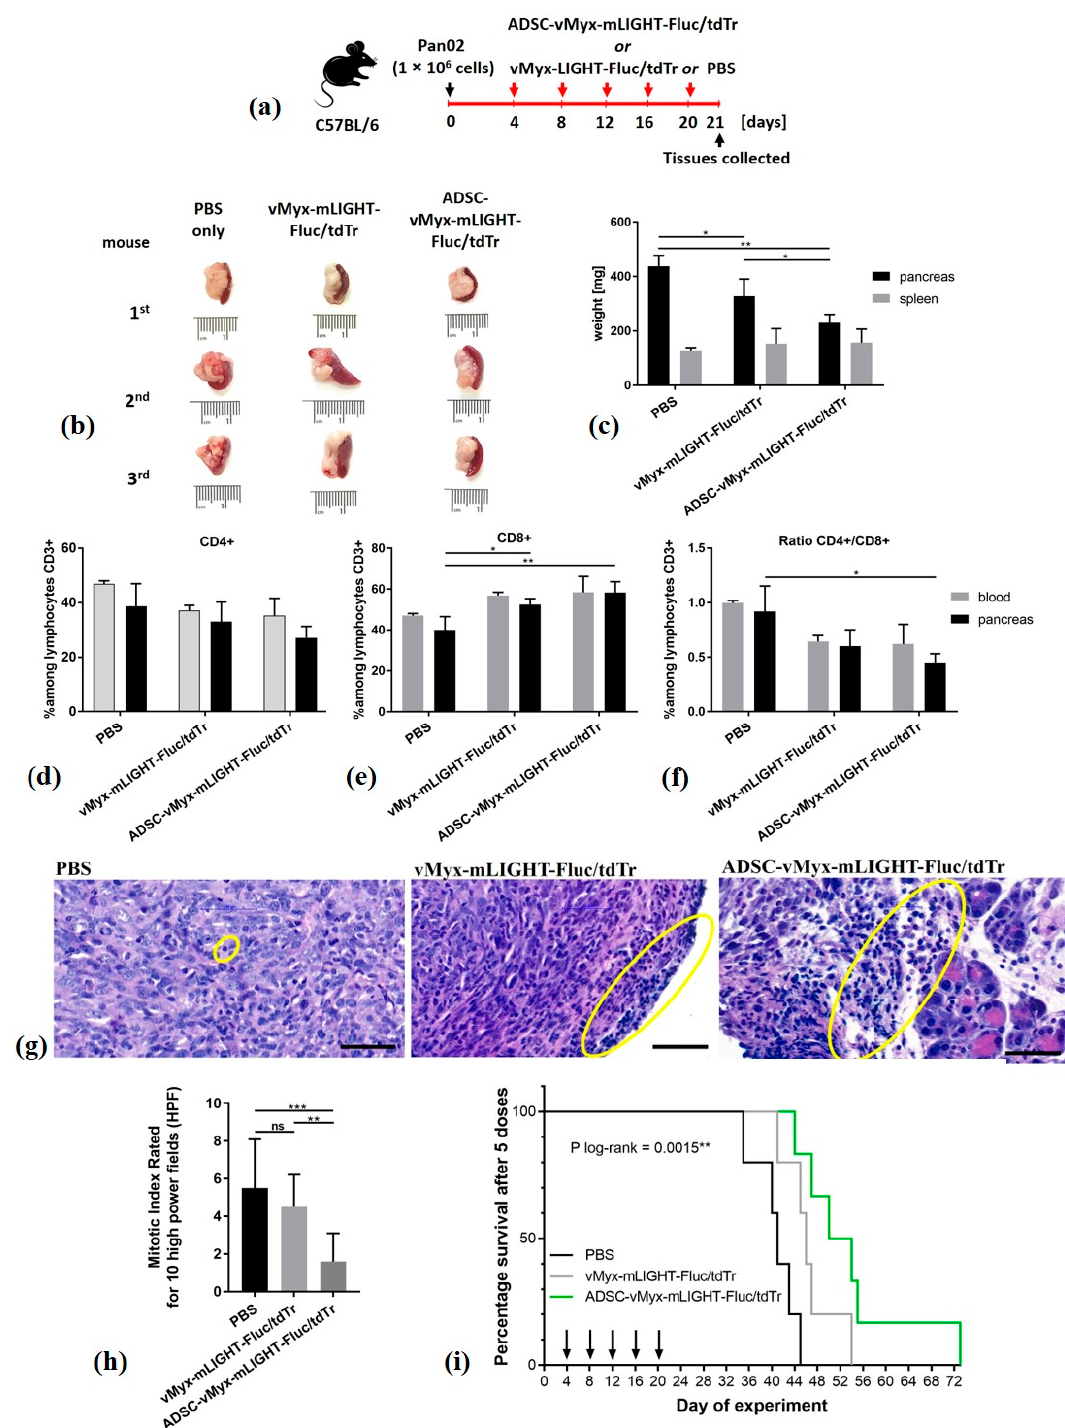
Figure 6. Therapy of experimental pancreatic adenocarcinoma using armed MYXV construct. C57Bl/6NCrl mice ( n = 10–11) with induced orthotopic lesions were injected IP (days 4, 8, 12, 16 and 20) with LIGHT-expressing vMyx-mLIGHT-Fluc/tdTr, either ADSC-shielded or unshielded, or with PBS − ; ( a ) timeline of experiment; ( b ) size of pancreata, 21st day; ( c ) weight of pancreata and spleen, 21st day; ( d – f ) flow cytometry data showing CD4+ and CD8+ cell percentages among CD3+ lymphocytes in the blood and pancreas; ( g ) histological appearance of representative H&E-stained sections (scale bars: 50 μ m, magn. 48×): lymphocytic infiltrates: yellow ellipses, ( h ) mitotic index rated under 400× magnification for 10 high power fields (HPF); ( i ) mouse survival ( n = 7–8): log-rank (Mantel–Cox) test; p = 0.0015. The data (mean ± SD) were analyzed with one-way ANOVA; statistically significant differences are indicated (* p ≤ 0.05; ** p ≤ 0.01; *** p ≤ 0.001; ns – not